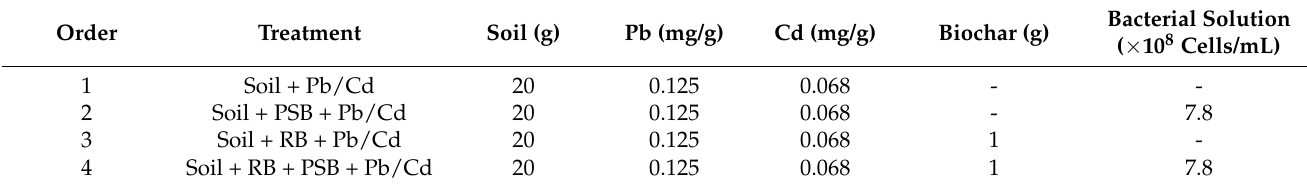
Table 2. Composition of all the treatments (RB—rice husk biochar, PSB— Enterobacter